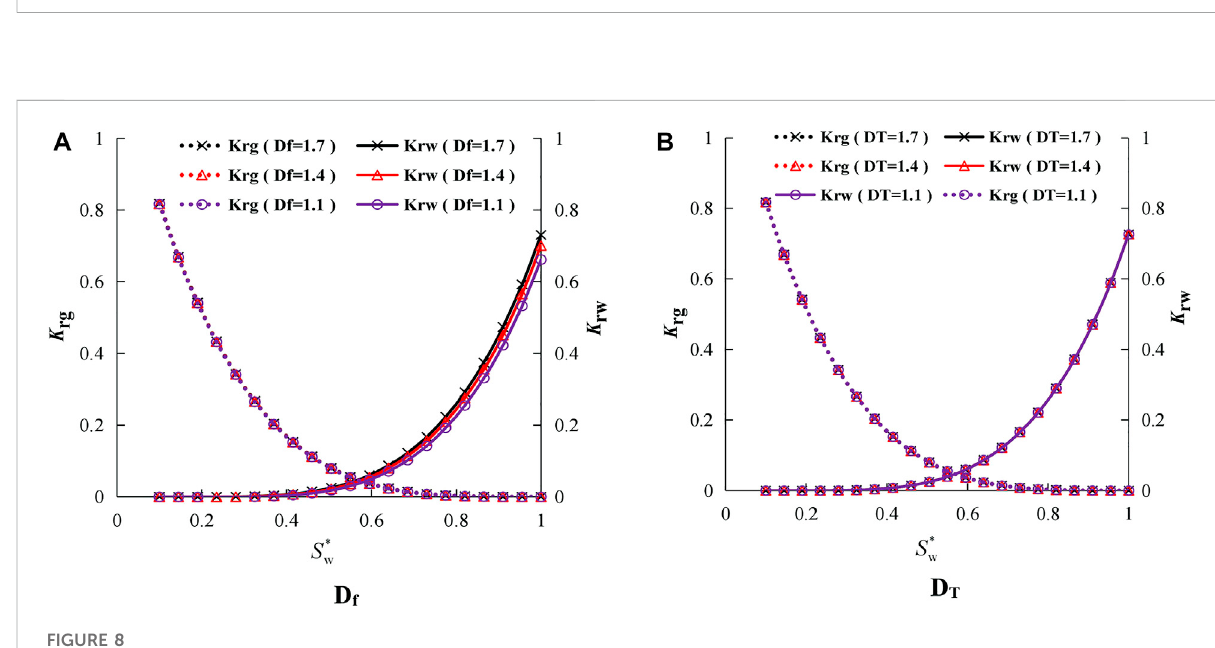
Effect of structural parameters on the two-phase relative